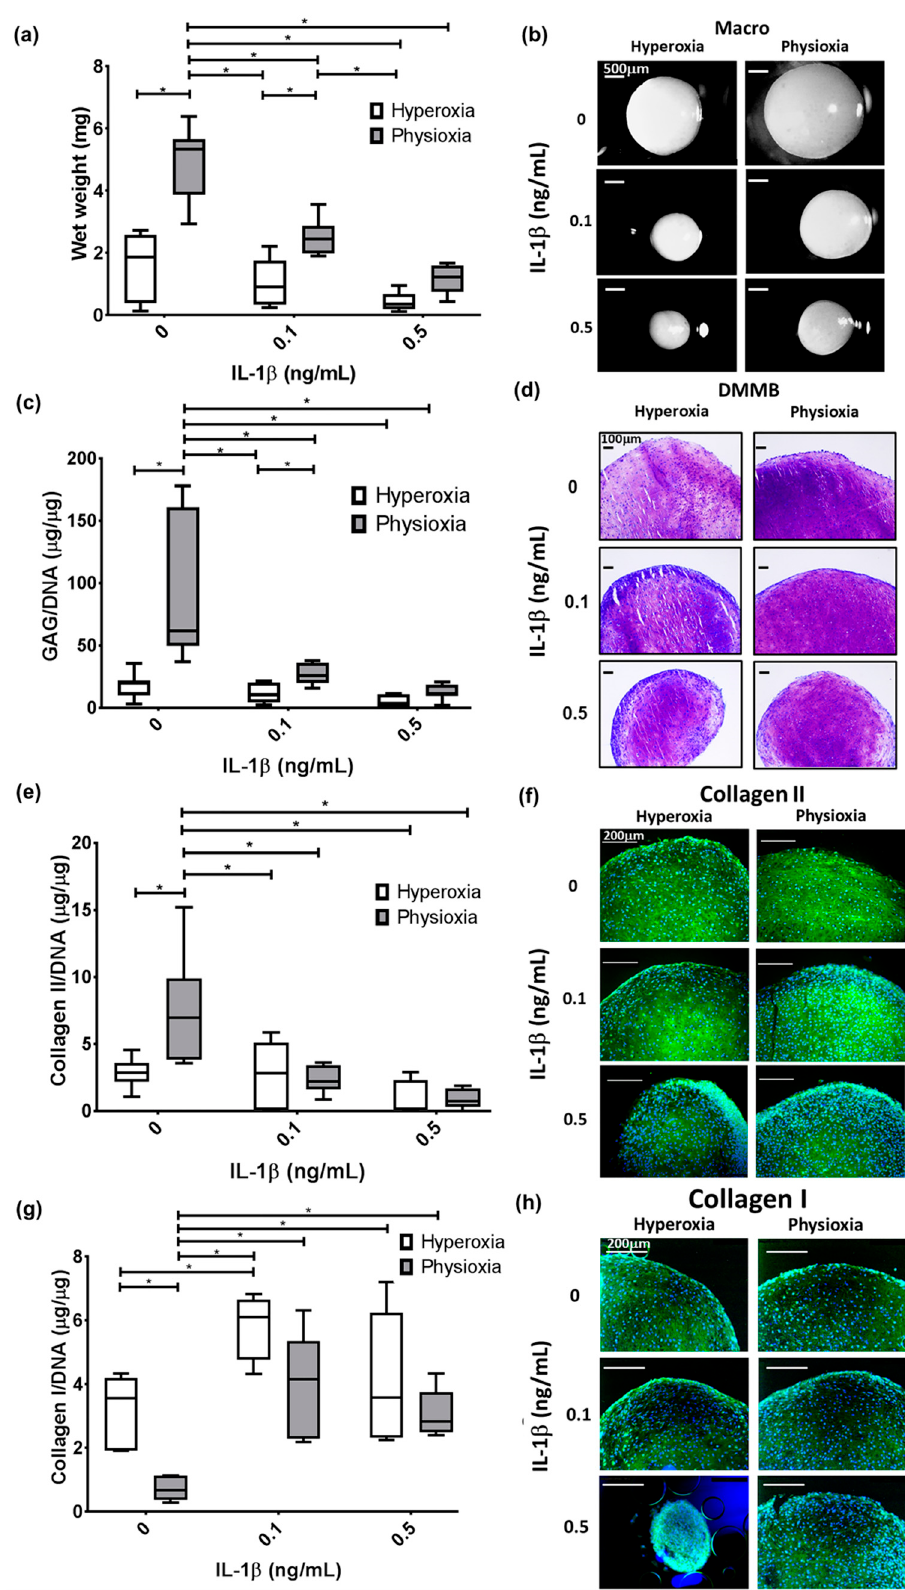
Figure 4. Pellet ( a ) wet weight, ( c ) GAG, ( e ) collagen II and ( g ) collagen I content in physioxia responsive donors in the presence of IL-1 β . Box plot represent median ± I.Q:R: of n = 7 donors; * p < 0.05. Representative ( b ) macroscopic, ( d ) DMMB, ( f ) collagen II and ( h ) collagen I-stained pellets of a responsive donor under physioxia and hyperoxia.